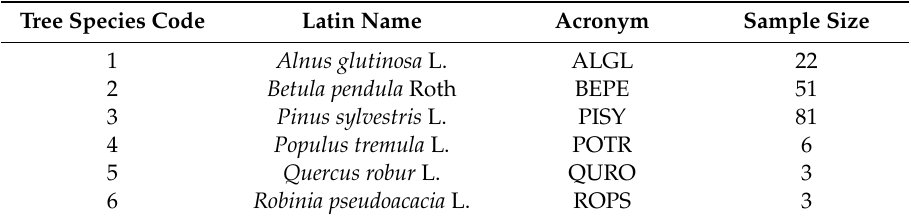
Table 2. Training dataset for tree species